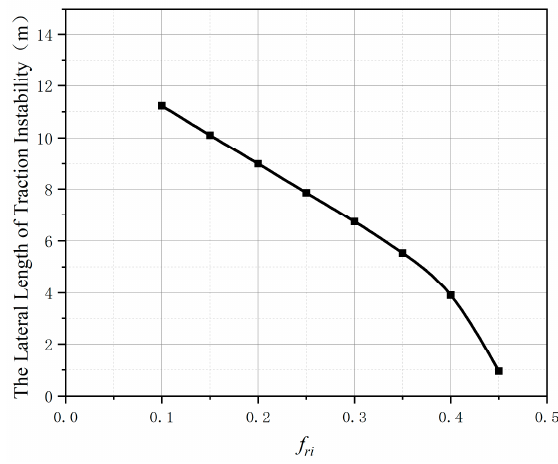
Figure 17. Influence of f ri on the lateral length of traction instability.